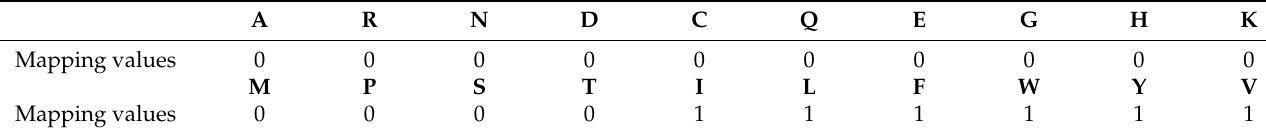
Table 1. Mapping values of topological